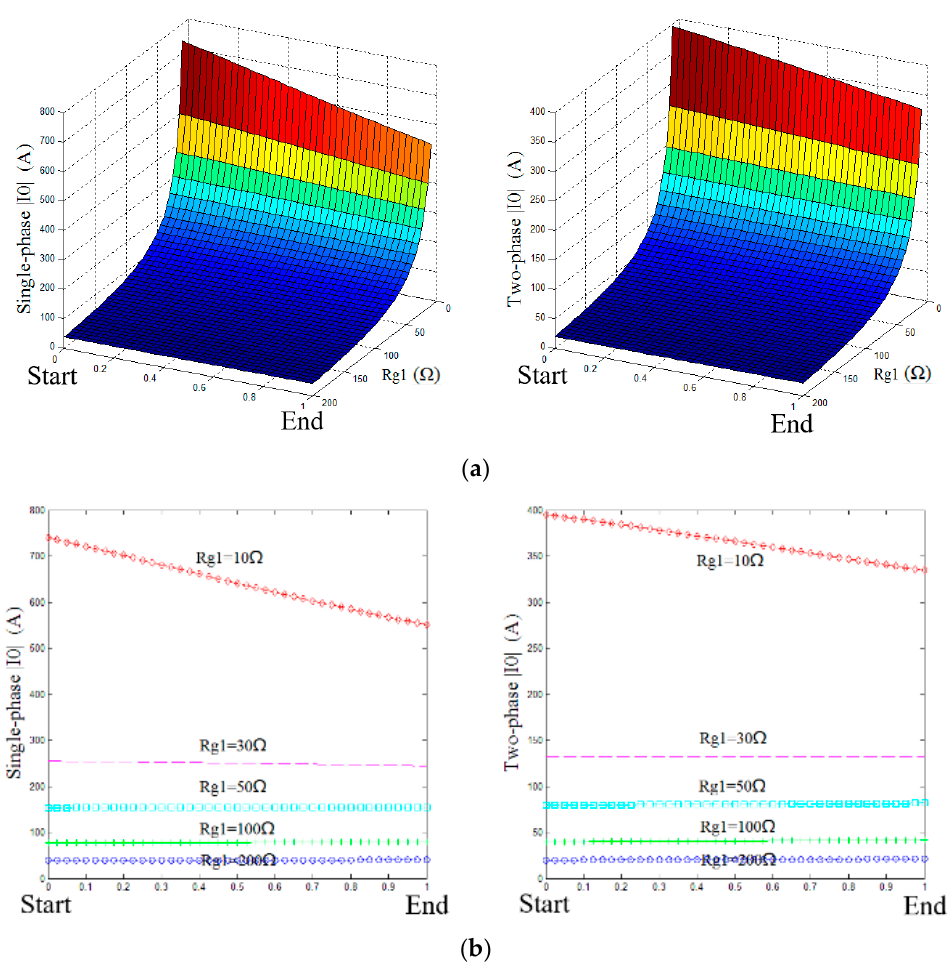
Figure 12. Characteristics of the zero-sequence current | I 0 | with respect to the fault location and Rg 1. ( a ) Change surface of the zero-sequence current | I 0 | with respect to the fault location and Rg 1; ( b ) change curve of the zero-sequence current | I 0 | with respect to the fault location at the different Rg 1 condition.